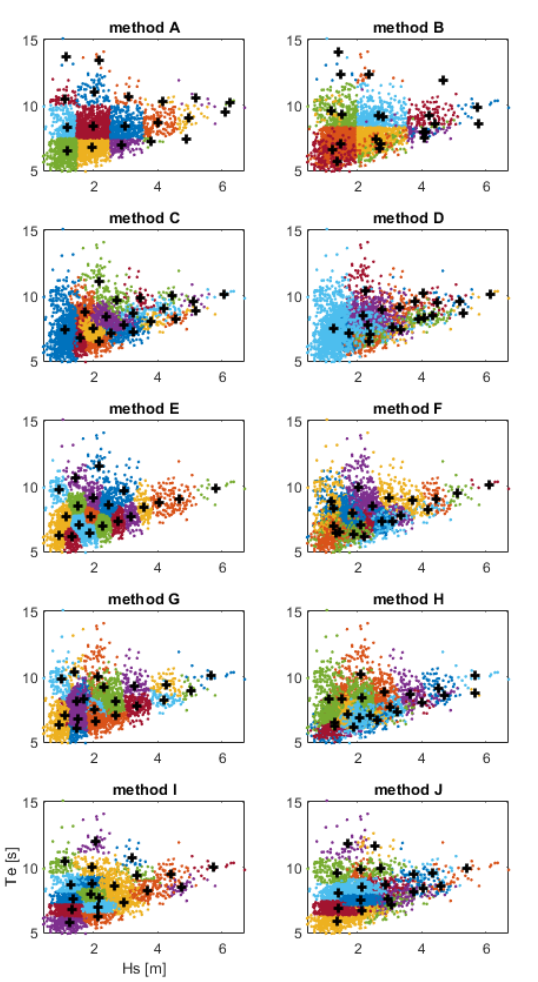
Fig. 3. Regrouping results and their representative sea states (black cross) in Hs-Te space for HF radar data when K =20. Members in the same group are of the same